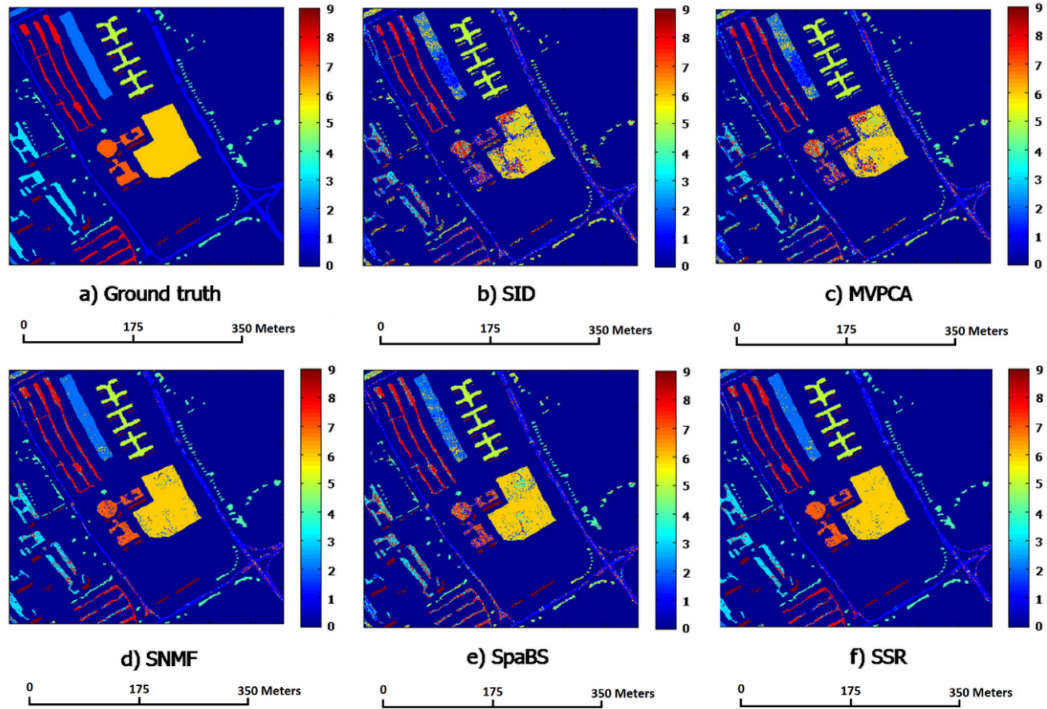
Figure 5. Classification maps of all five methods on PaviaU dataset using the SVM classifier. ( a ) Ground